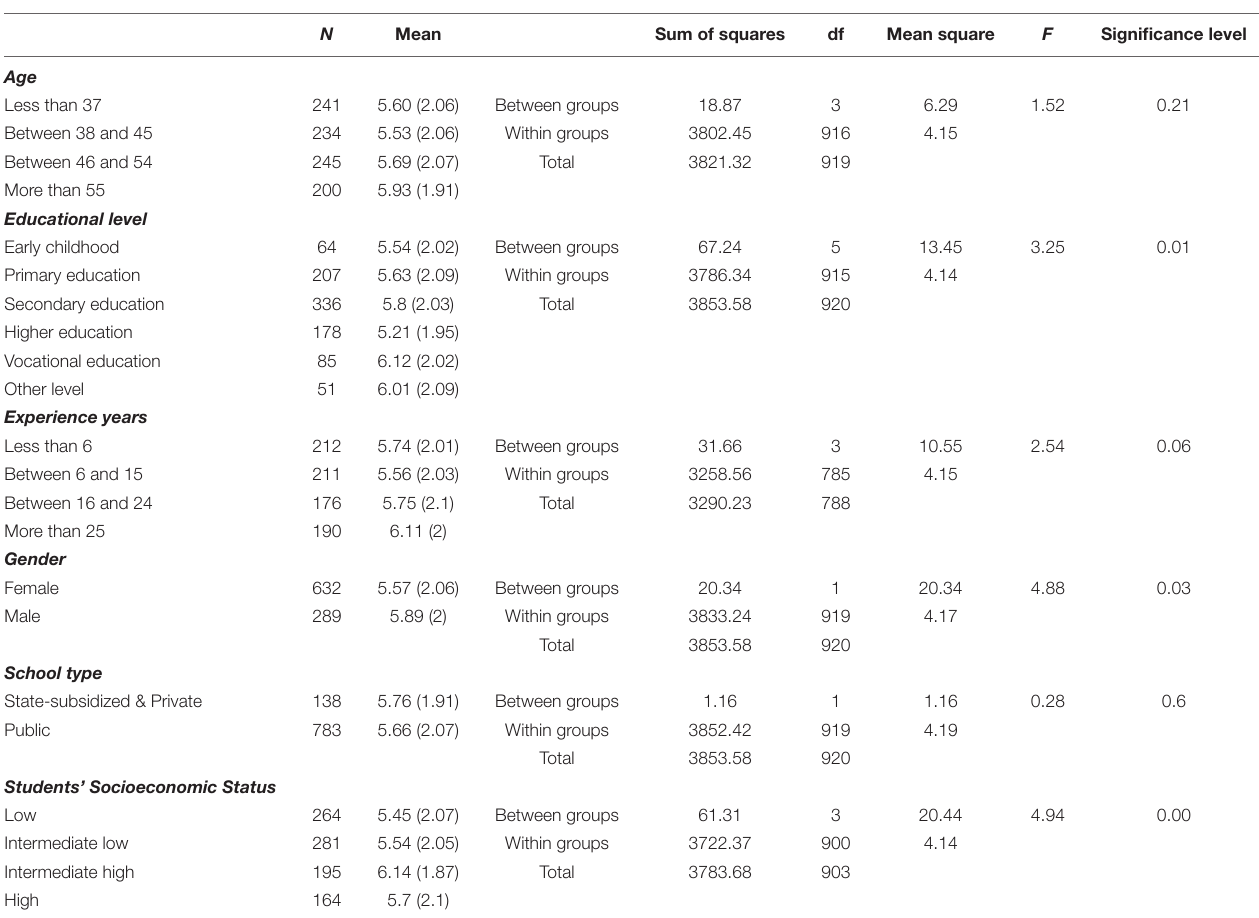
TABLE 6 | ANOVA results for teachers’ motivation during emergency remote